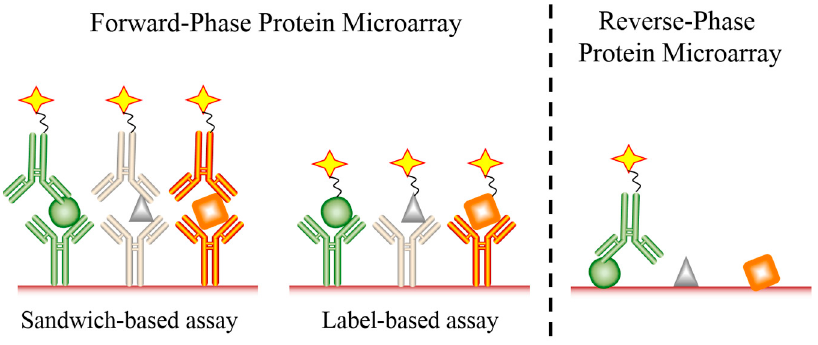
Figure 2. An illustration of both forward and reverse-phase protein microarrays. Proteins are identified as circles, triangles and squares. Detection fluorophores or enzymes are identified as stars.